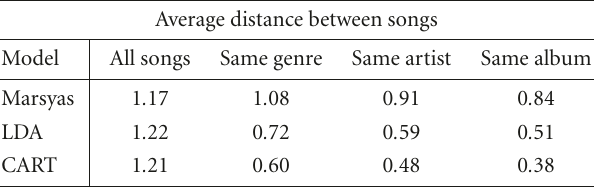
Table 3: Statistics of the distance measure.